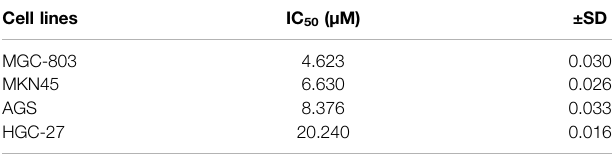
TABLE 1 | IC 50 values of SIM treatment on four GC cell